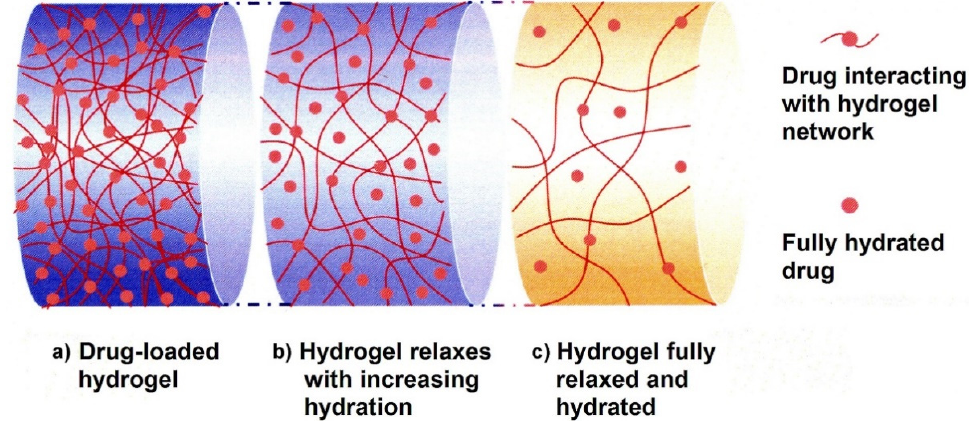
Figure 15. Schematic illustration of the process of drug release from hydrogel. Reprinted with permission from Ref. [131]. Copyright 2017 Elsevier.